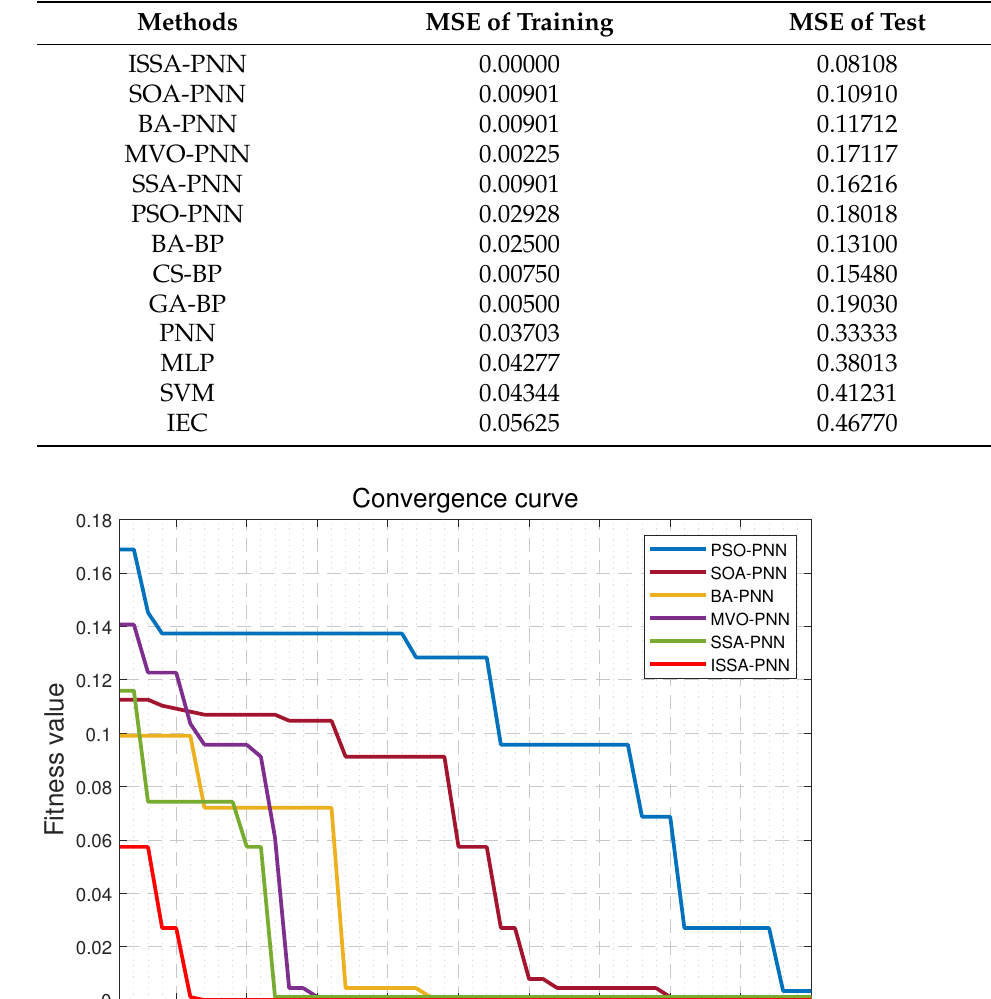
Table 9. Comparison of sample errors.